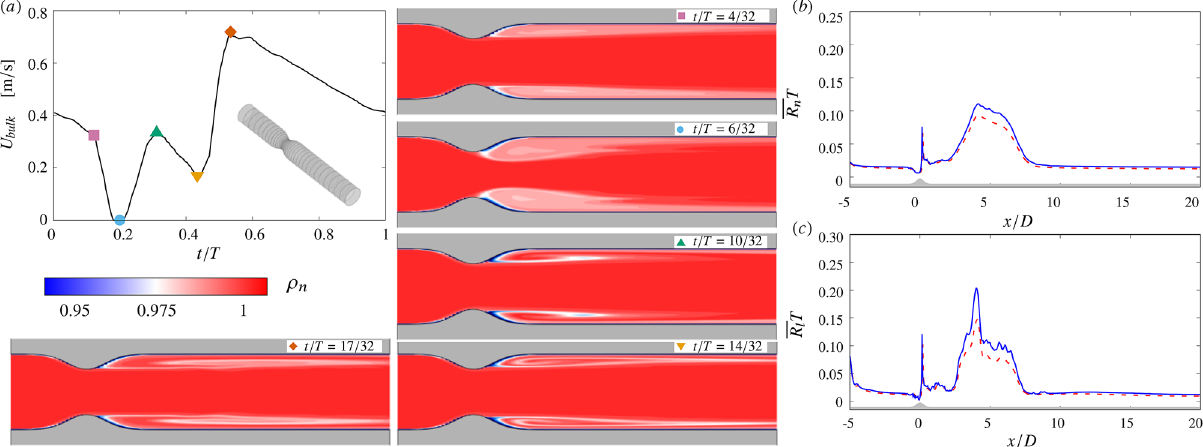
Figure 2. Leukocyte transport and adhesion inside an ideal stenotic artery. ( a ) Blood flow velocity U bulk and visualizations of neutrophil concentration ρ n (normalized by the reference value, 4.34 × 10 9 / l ) throughout the cardiac cycle ( T is the cardiac period). The inset in the cardiac cycle panel shows the three-dimensional geometry of the ideal artery. ( b,c ) adhesion of leukocytes ( b , neutrophils; c lymphocytes) as a function of the distance along the artery ( x = 0 is the axial location of the minimum lumen area, D the diameter of the healthy tract): — without tracking the particle concentration 22 ; - - - - - with concentration tracking (Eq. 1, present